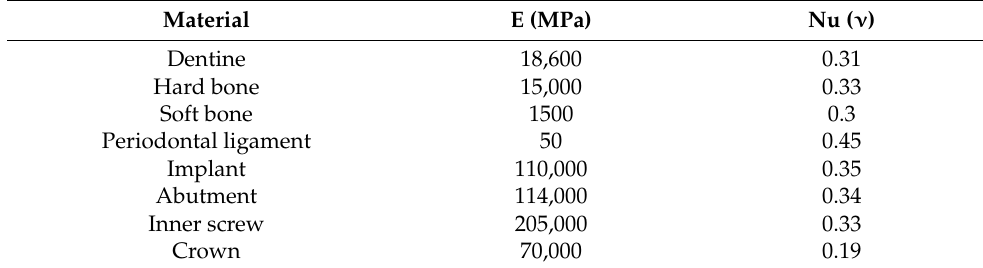
Table 2. Material properties used in preparing the finite element model.